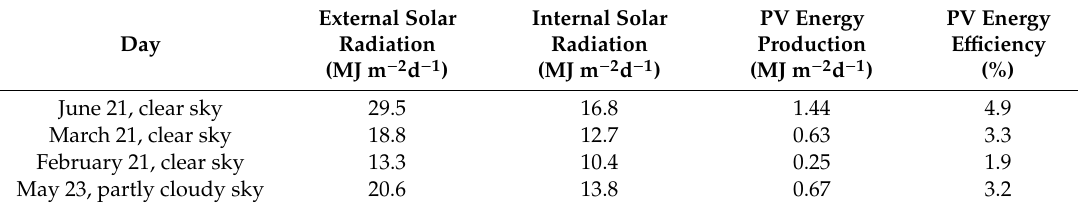
Table 1. External and internal solar daily radiation of the prototype and electricity production of the PV panels.